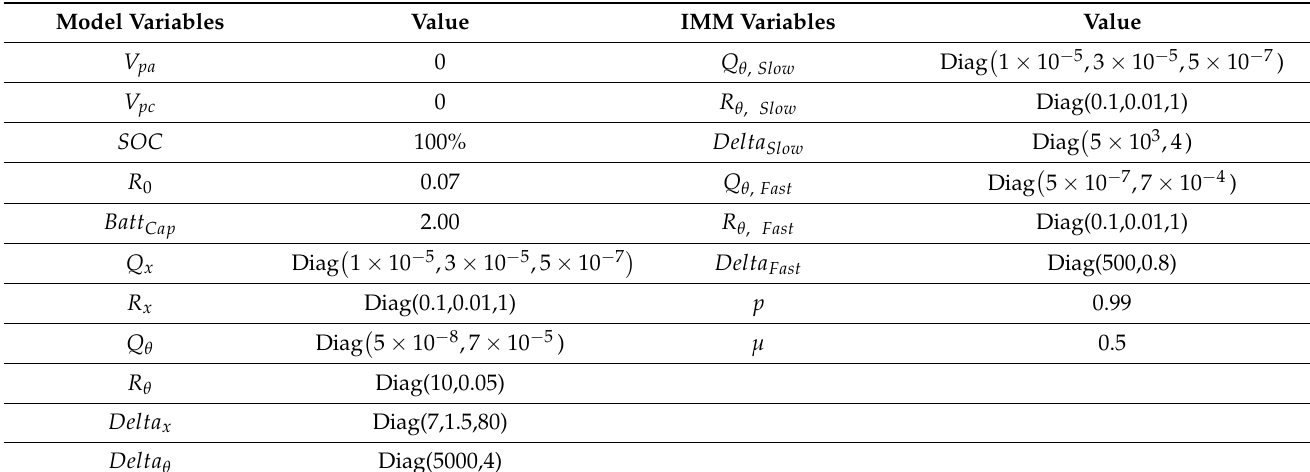
Table 3. Dual Filter and IMM Initial